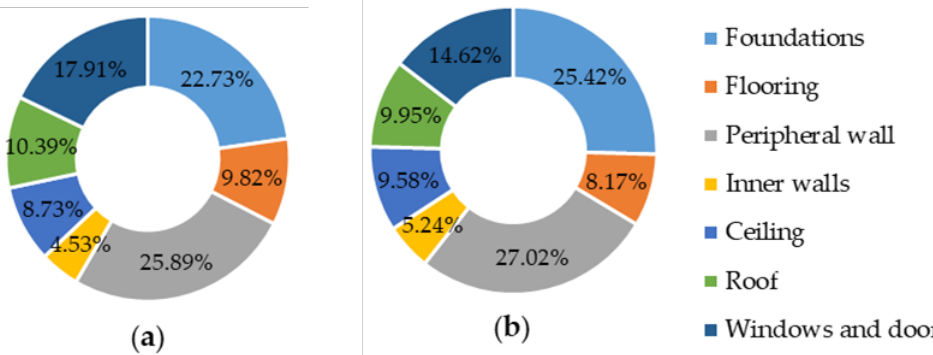
Figure 8. Impact distribution of construction components on: ( a ) acidification; ( b ) eutrophication.